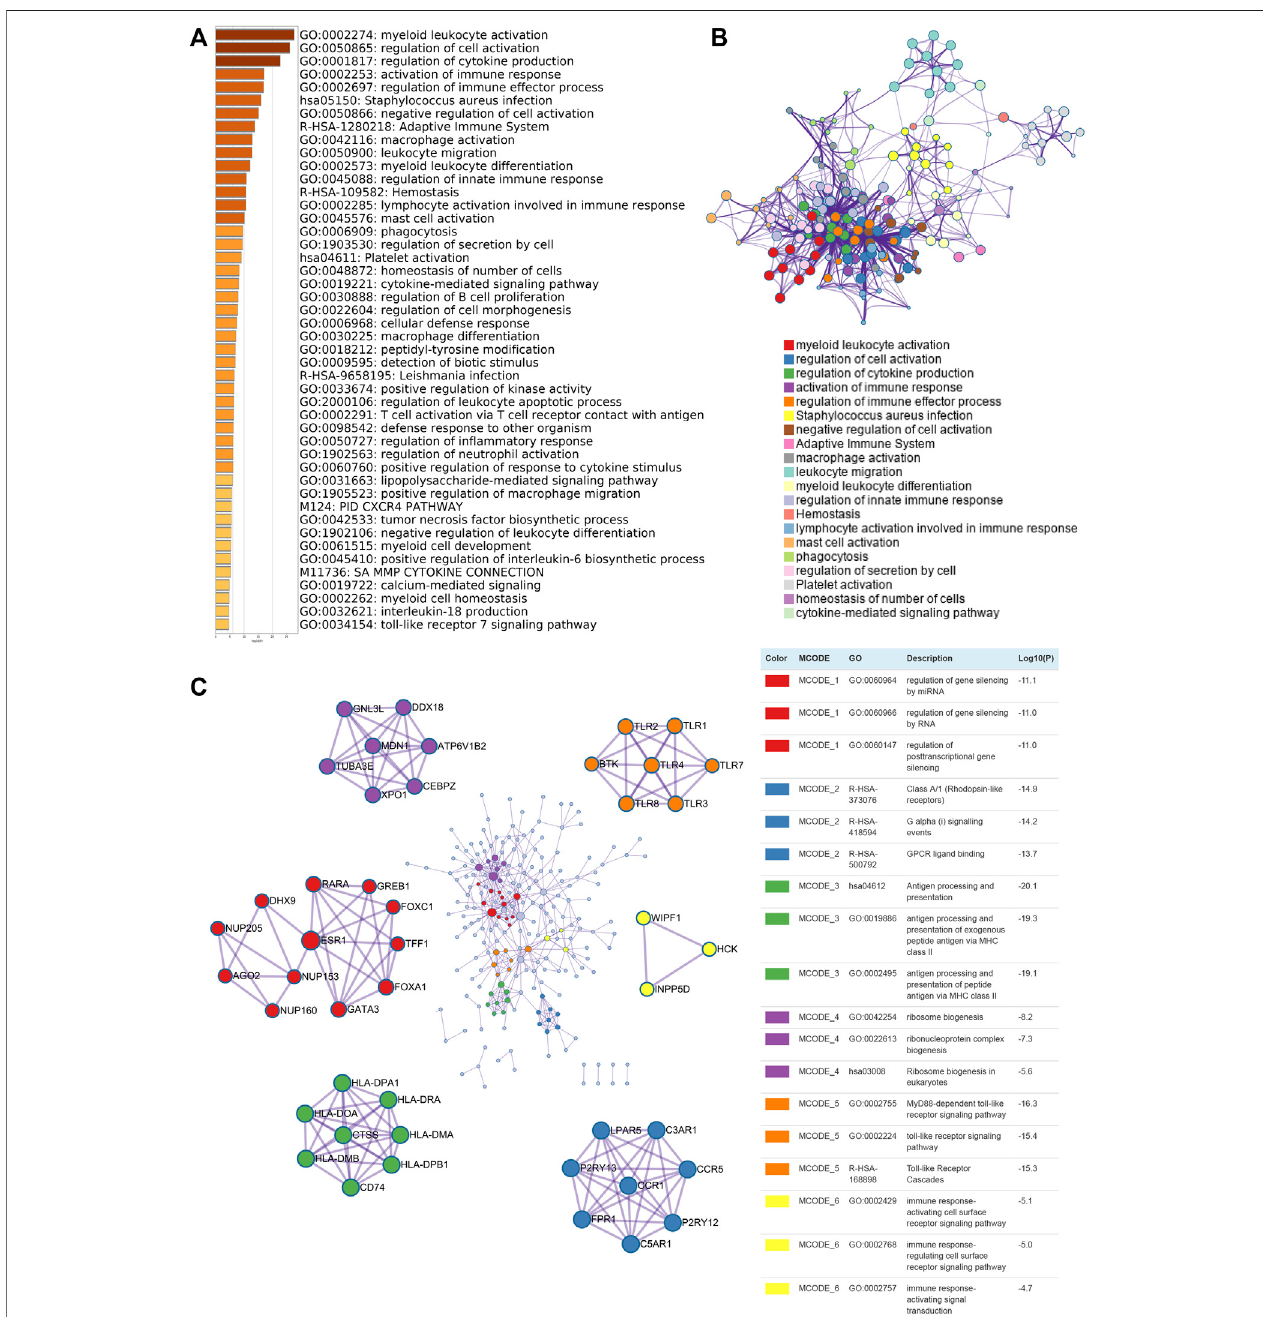
FIGURE 3 | Biological function enrichment of KCNK gene family in breast cancer. (A) Heatmap of GO enriched terms colored by p -values. (B) Network of GO function and pathway enrichment analysis of KCNKs which was colored by cluster. (C) Protein-protein interaction (PPI) enrichment network analysis of KCNK related genes in breast